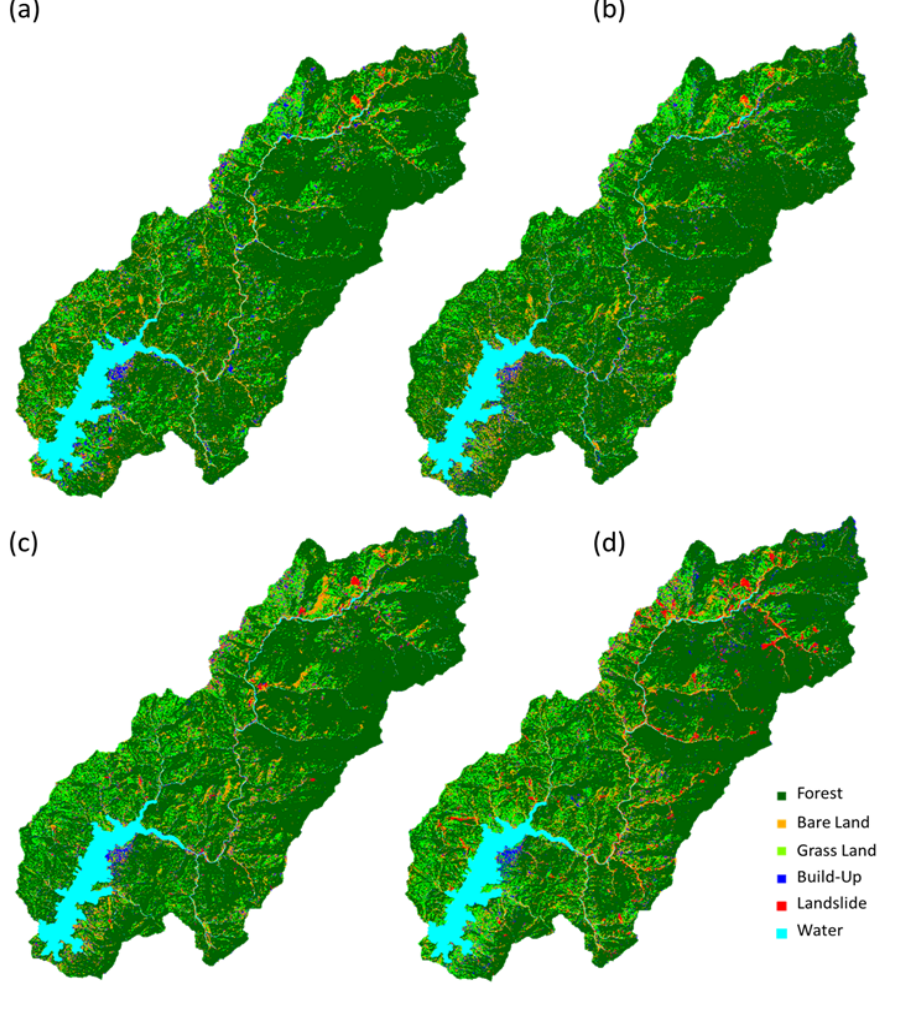
Figure 3. Land use change percentage from 2001 to